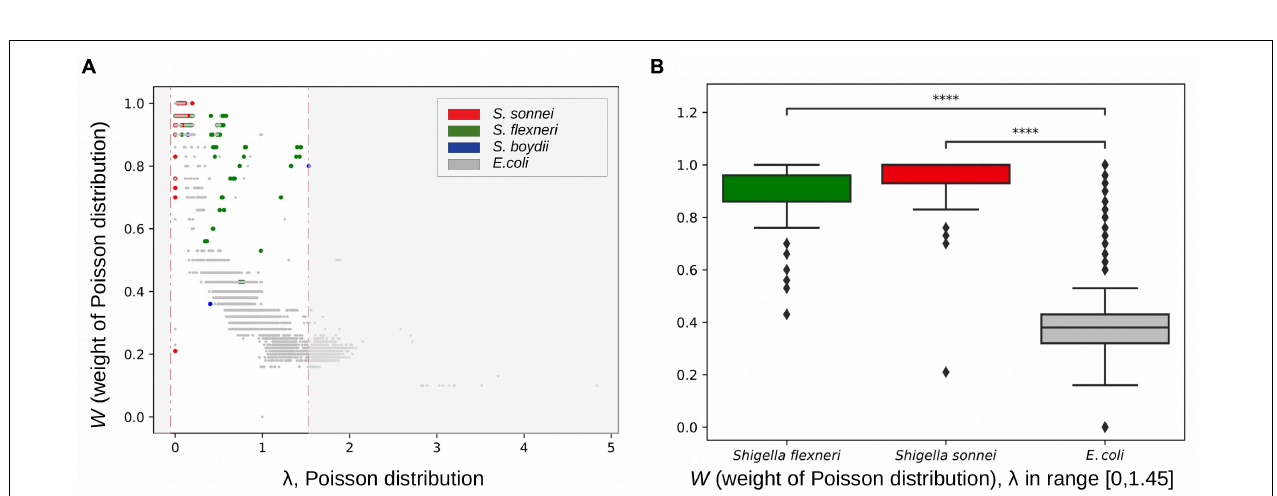
FIGURE 9 | Rates of homologous recombination. (A) Fractions of vertically inherited fragments in strains from the B1 phylogroup calculated as the weight of the Poisson distribution (see section “Materials and Methods”). (B) The weight of the Poisson distribution in Shigella and E. coli in the same interval of evolutionary distances between strains. **** p <